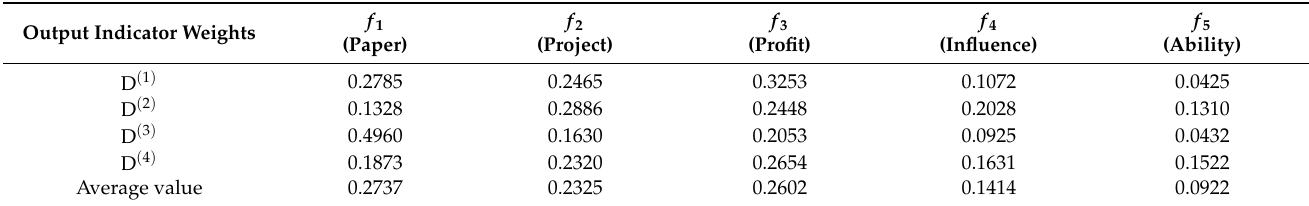
Table 4. Output indicator weights.